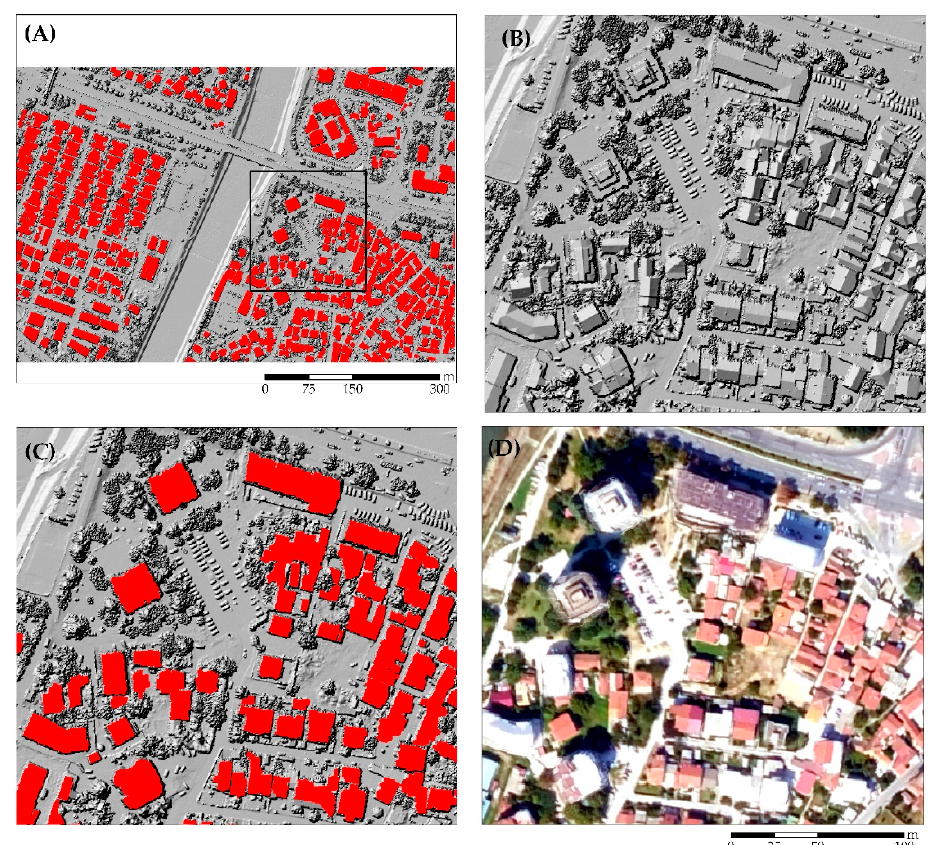
Figure 9. Classification results; ( A ) building classification over hillshade; ( B ) hillshade data; ( C )